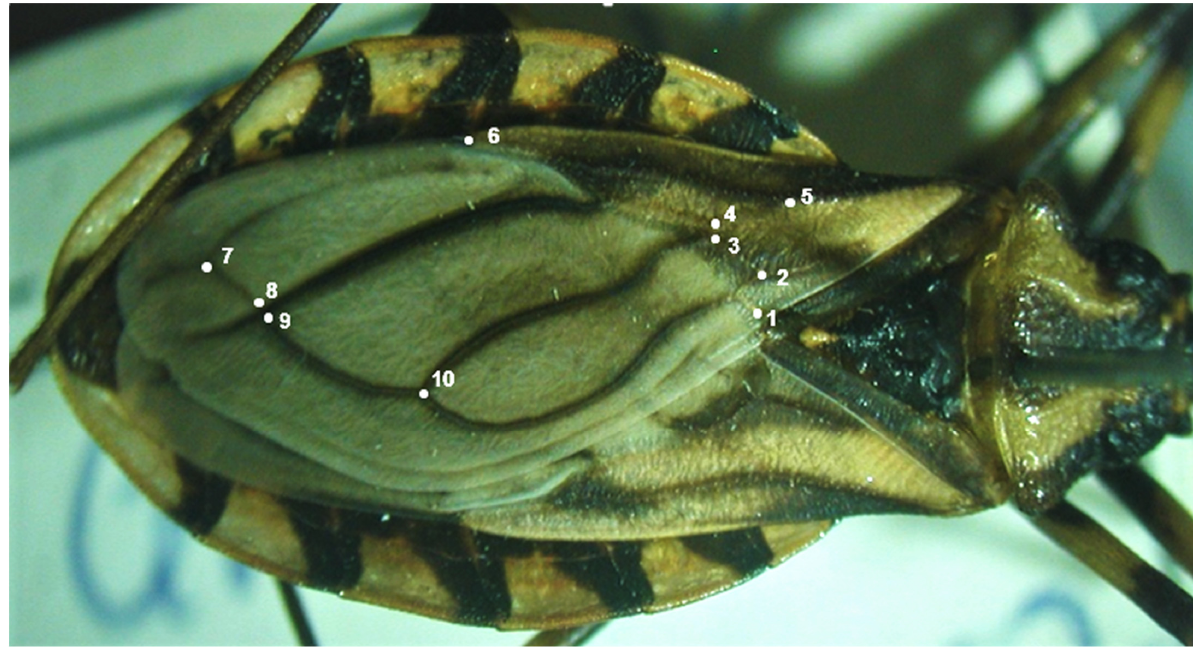
Figure 1. Image of the left wing of a male of Triatoma brasiliensis brasiliensis Neiva, 1911 showing the selected 10 landmarks: 1. Intersection of Pcu and Pcu (postocubitus) + first anal vein; 2. Intersection of Cu (cubitus) and Cu–postocubitus (Cu–Pcu); 3. Intersection of Cu and M–Cu; 4. Intersection of media and cubitus (M–Cu); 5. Bifurcation of the radius (R) and median (M) veins; 6. Membrane portion on radius vein; 7. First intersection of R + M and Pcu (postocubitus); 8 Second intersection of R + M and Pcu ; 9. Intersection of M and extension of Cu–Pcu veins; 10. Intersection of Pcu and Cu.